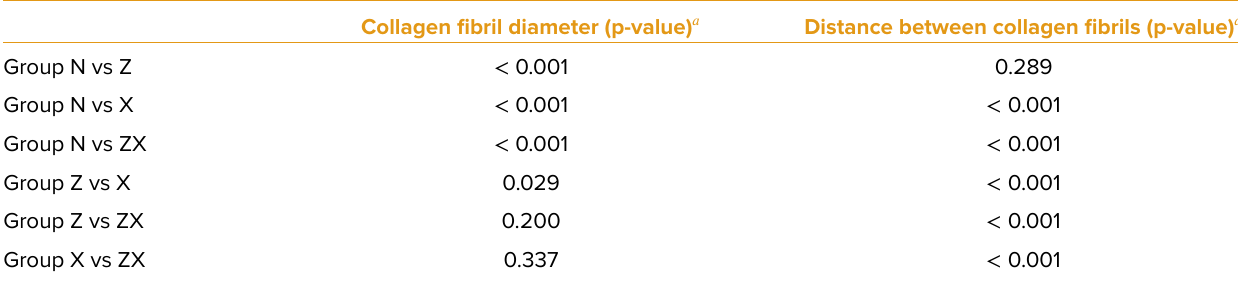
Table 3. Between groups comparison of collagen fibril diameter and distance between fibrils. Collagen fibril diameter (p-value) 𝑎 Distance between collagen fibrils (p-value) 𝑎 Group N vs